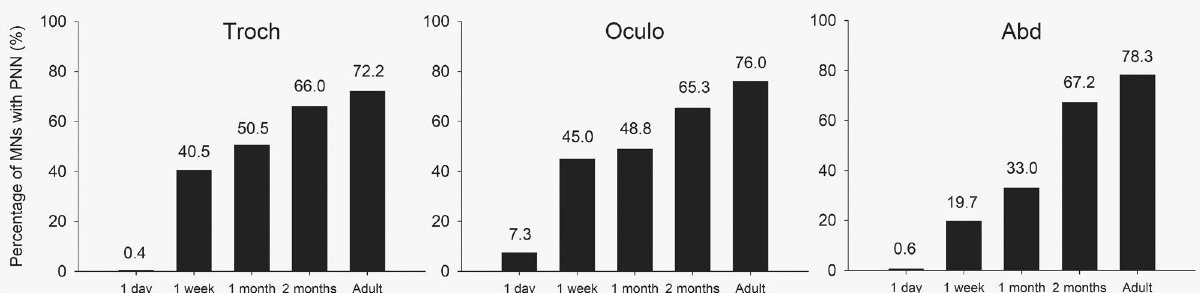
Figure 9. Percentage of PNN bearing cholinergic motoneurons in the extraocular motor nuclei, based on WFA labelling, at different postnatal developmental phases. These proportions of motoneurons with PNNs are significantly different among the developmental phases in all three nuclei ( χ 2 (4, n = 1139) = 284.9, p < 0.001; χ 2 (4, n = 1199) = 321.3, p < 0.001 and χ 2 (4, n = 1053) = 346.7 p < 0.001 for the trochlear-, oculomotor- and abducens nuclei,